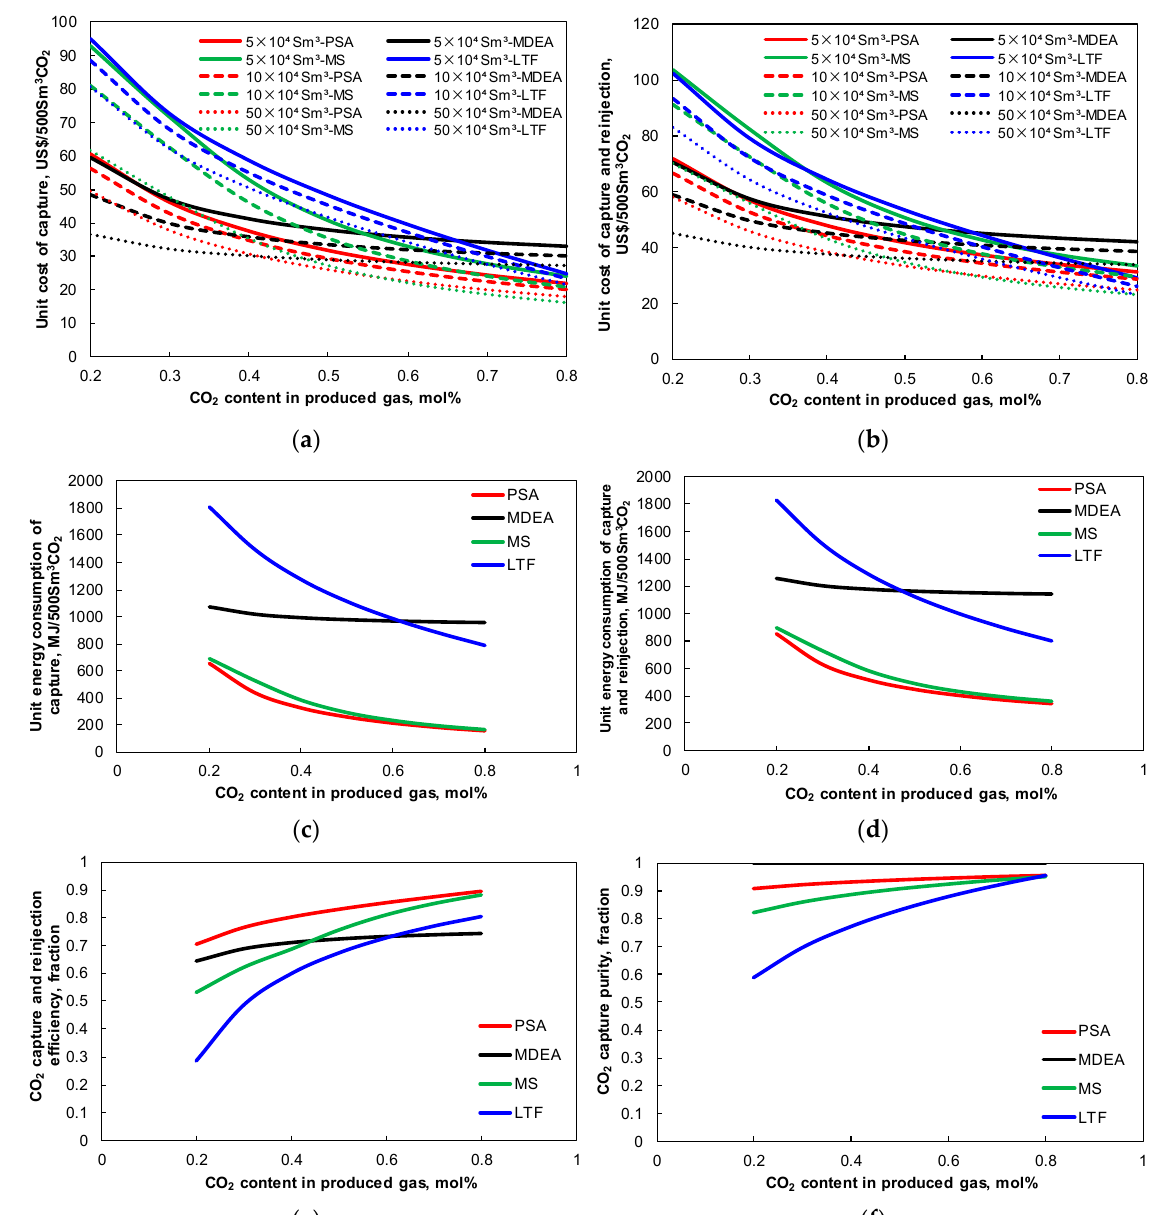
Figure 6. Calculation results of the evaluation indicators of the CCRPs at different gas production conditions. ( a ) Unit cost of CO 2 capture; ( b ) Unit cost of CO 2 capture and reinjection; ( c ) Unit energy consumption of CO 2 capture; ( d ) Unit energy consumption of CO 2 capture and reinjection; ( e ) CO 2 capture and reinjection efficiency; ( f ) CO 2 capture